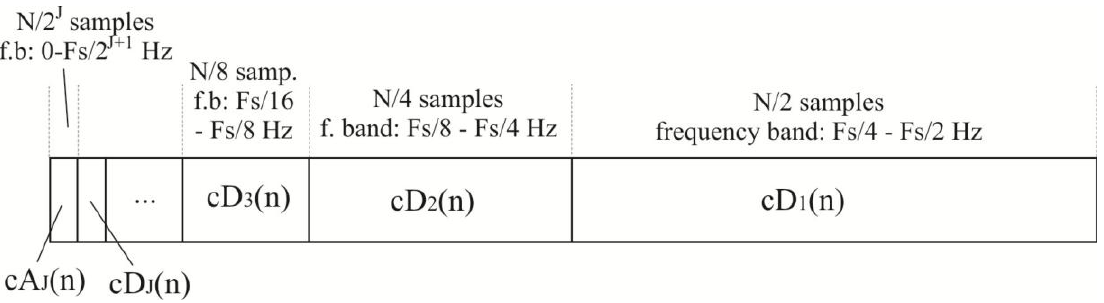
Figure 6. Wavelet coefficients concatenated into